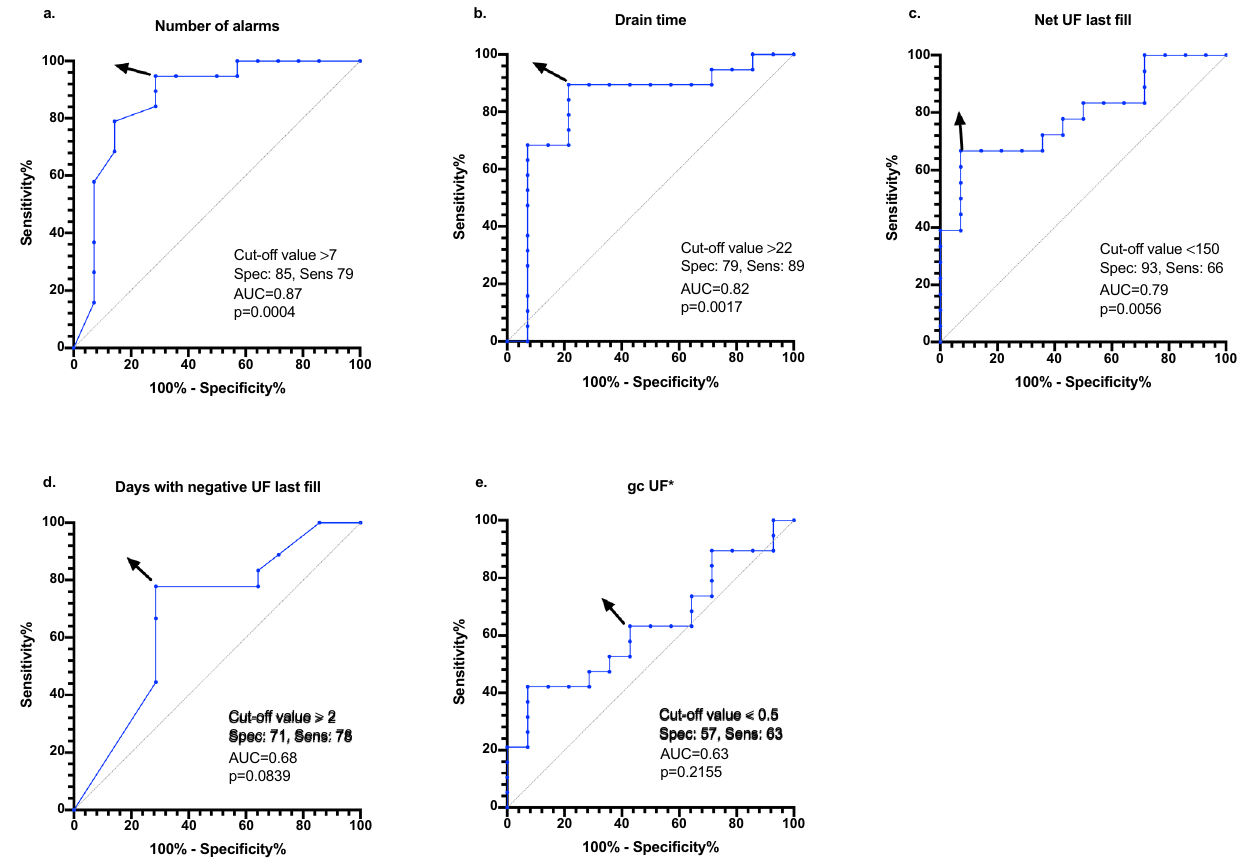
Figure 1. Receiver operator characteristic (ROC) curves for the parameters obtained from APD cycler card management software in the cases and the controls. The arrow indicates the point corresponding to the cut-off value selected. AUC = area under the curve. ( a ) Total number of alarms per week; ( b ) total drain time at the end of cycler session; ( c ) mean net UF of last fill; ( d ) days with negative UF of last fill; ( e ) mean gcUF during cycler treatment (*not included in further analysis).